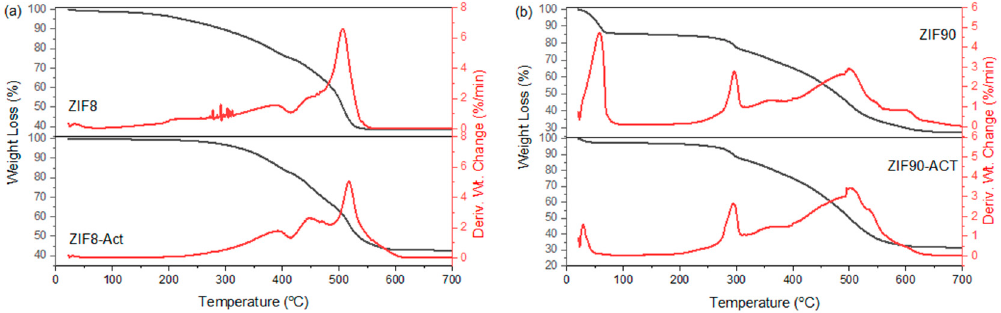
Figure 2. DTG/TG curves of as synthesized and activated ( a ) ZIF-8 and ( b ) ZIF-90. SEM analysis was used as an additional tool to determine if the as-synthesized samples were phase-pure, confirm the morphology of the ZIFs and estimate the particle size. SEM images (Figure 3) confirmed, as with PXRD, that the as-synthesized ZIF-8 and ZIF-90 were phase-pure samples. These images also indicated that a sodalite topology was formed for both ZIFs (cubic). However, ZIF-8 (Figure 3a) was seen in individual particles while agglomerates were formed in ZIF-90 (Figure 3b). Finally, the diameter of the ZIF-8 particles was estimated to be approx. 90 µ m. The diameter of the individual particles in the ZIF-90 agglomerate was estimated to be in range of 100 to 200 nm, with an average of 150 nm. This significant difference in diameter size correlates with the difference noted by the calculated crystallite sizes from PXRD. However, the primary particle size, calculated from XRPD, was even smaller (i.e., 400 nm for ZIF-8 and 20 nm for ZIF-90), which indicates that the individual particles seen in the SEM images are not single crystals, but rather, are polycrystalline.